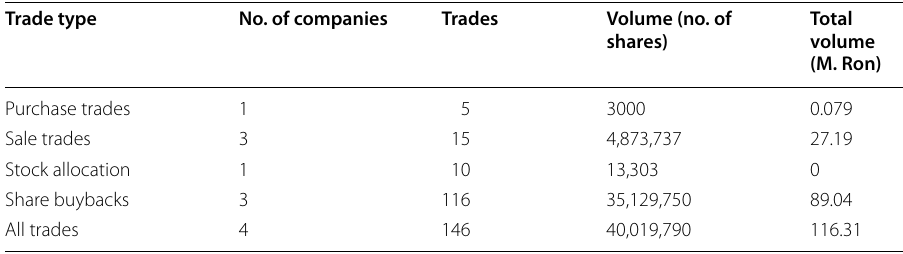
Table 2 Summary of insider trades Trade